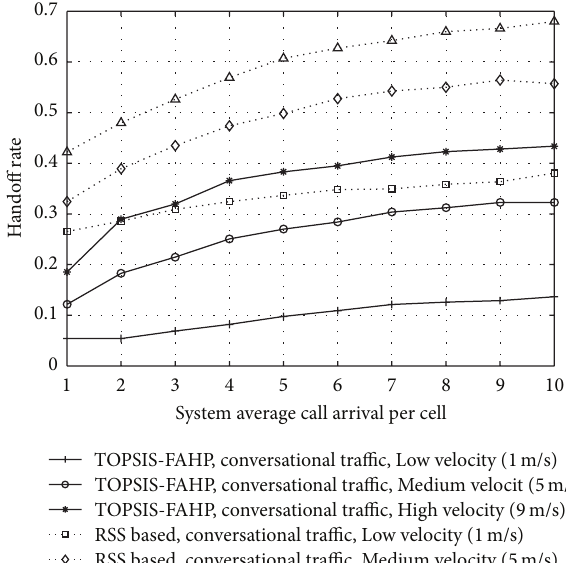
Figure 7: Outage probability using FTOPSIS.